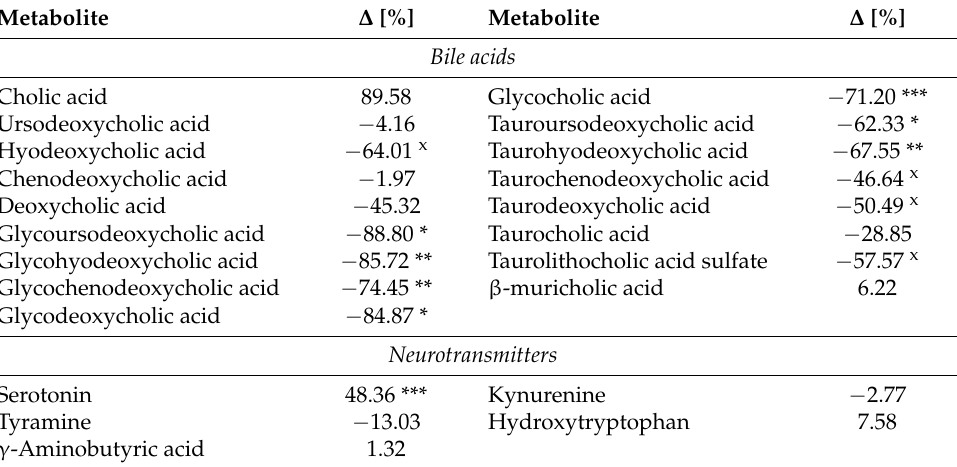
Table 5. LC-MS targeted analysis of bile acids and neurotransmitters in